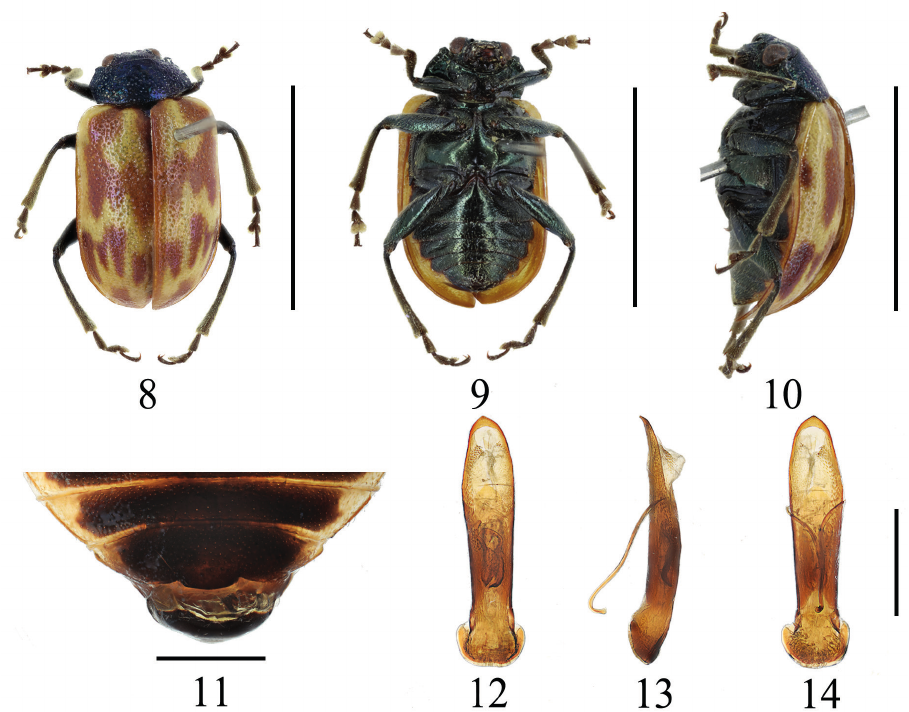
11 ventral view of 5 th ventrite, male 12 aedeagus, dorsal view 13 ditto, lateral view 14 ditto, ventral view. Scale bars: 5 mm ( 8–10 ); 1 mm ( 11–14